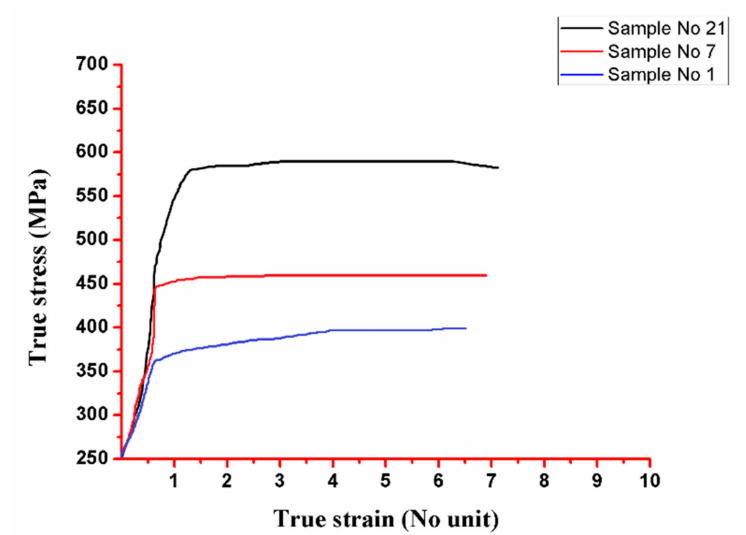
Figure 10. True stress and true strain of three di ff erent (sample No. 1 = 372 MPa tensile strength, sample No. 7 = 438 MPa tensile strength, and sample No. 21 = 560 MPa tensile strength) specimens subjected to FWTPET + FSP technique.